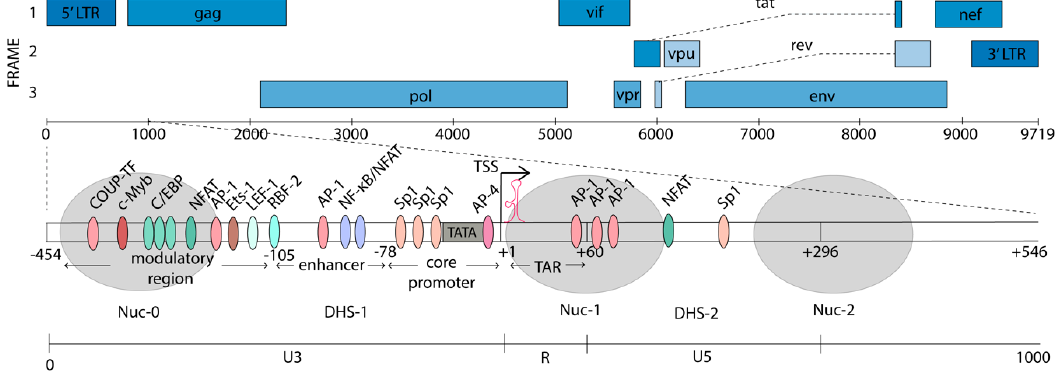
Figure 1. Structure of the HIV-1 promoter. The integrated HIV-1 genome is 9719 nucleotides in length. It includes two copies of the LTR which consist of a U3, R and U5 region, shown in the bottom panel. The genome encodes 9 genes which are shown in the top panel. The 5’LTR serves as the promoter for HIV-1 and is divided into the modulatory, enhancer, core promoter and TAR regions (shown enlarged in the middle panel). The binding sites for some of the ~50 TFs known to interact with the HIV-1 promoter are shown by colored ovals. The TATA box is shown by the grey rectangle, which serves as the binding site for the TATA binding protein (TBP) as part of the general transcription factor TFIID, to allow formation of the pre-initiation complex, just before the transcription start site (TSS), marked by the black arrow. The positions of the three nucleosomes, (Nuc-0, -1, and -2) on the HIV-1 5’LTR are marked by the grey shaded ovals. The DNase hypersensitivity regions (DHS-1 and -2) are the nucleosome-free regions on the